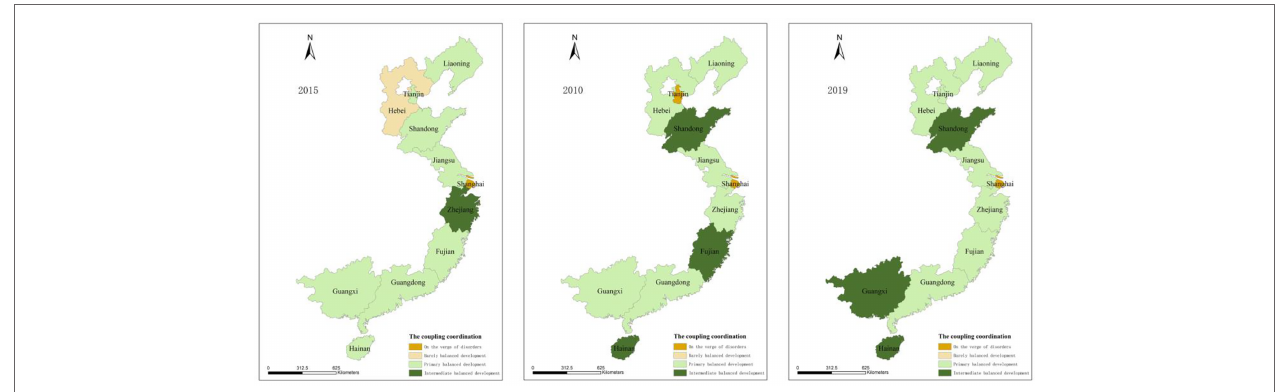
FIGURE 3 | Coupling coordination degree of China’s 11 coastal areas in 2010, 2015, and